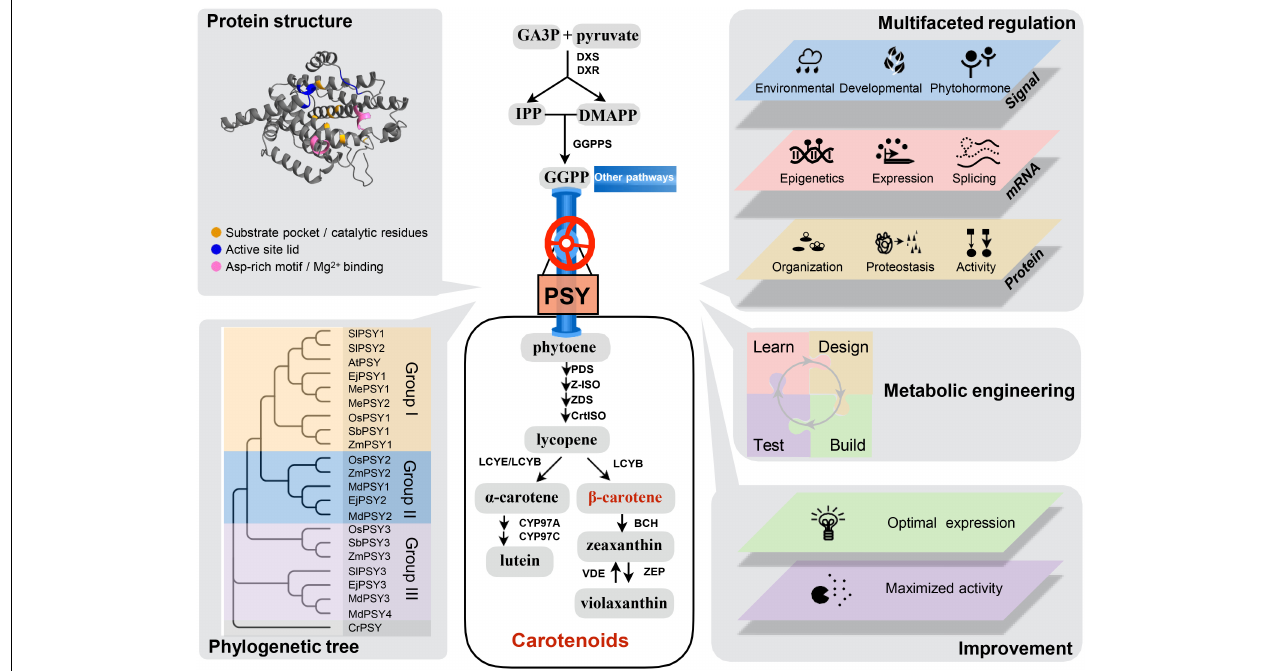
FIGURE 1 | Overview of plant carotenoid biosynthesis pathway and the biology of plant phytoene synthase. Carotenoid biosynthesis starts with GA3P and pyruvate to produce the direct precursor of GGPP. PSY is the first committed and major-rate limiting enzyme in the carotenoid biosynthesis pathway. β -carotene is the most potent provitamin A carotenoid. Abbreviations for metabolites and pathway enzymes can be found in Sun et al. (2022). Protein structure: A high confident structure prediction of Arabidopsis PSY protein (https://www.alphafold.ebi.ac.uk/entry/P37271) with conserved motifs of enzymatic active site indicated. Phylogenetic tree: Land plant PSY proteins can be divided into three large groups (I, II, and III) and PSY genes in each group show tissue-specific expression pattern. Multifaceted regulation: PSY gene expression and activity are under multifaceted regulation by various signals and factors at epigenetic, transcriptional, post-transcriptional, and post-translational levels. Metabolic engineering: PSY is the main target gene of carotenoid metabolic engineering. The design of genetic manipulation of PSY for carotenoid enrichment benefits from the learning process. Improvement: Further understanding of the regulatory mechanisms of PSY and maximization of its activity will enable predictable engineering and breeding to achieve the targeted goals of carotenoid improvement in crops. Sl, Solanum lycopersicum ; At, Arabidopsis thaliana ; Ej, Eriobotrya japonica ; Me, Manihot esculenta ; Os, Oryza sativa ; Sb, Sorghum bicolor ; Zm, Zea mays ; Md, Malus domestica ; Cr, Chlamydomonas reinhardtii . The database accession numbers of sequences used are: AtPSY (AAA32836), EjPSY1 (KF922363), EjPSY2A (KF922364), EjPSY3 (KF922367), MdPSY1 (KT189149), MdPSY2 (KT189150), MdPSY3 (KT189151), MdPSY4 (KT189152), MePSY1 (ACY42666), MePSY2 (ACY42670), OsPSY1 (AAS18307), OsPSY2 (AK073290), OsPSY3 (DQ356431), SbPSY1 (AY705389), SbPSY3 (AAW28997), SlPSY1 (ABM45873), SlPSY2 (ABU40771), SlPSY3 (Solyc01g005940), ZmPSY1 (AX13806), ZmPSY2 (AAQ91837), ZmPSY3 (DQ356430), and CrPSY